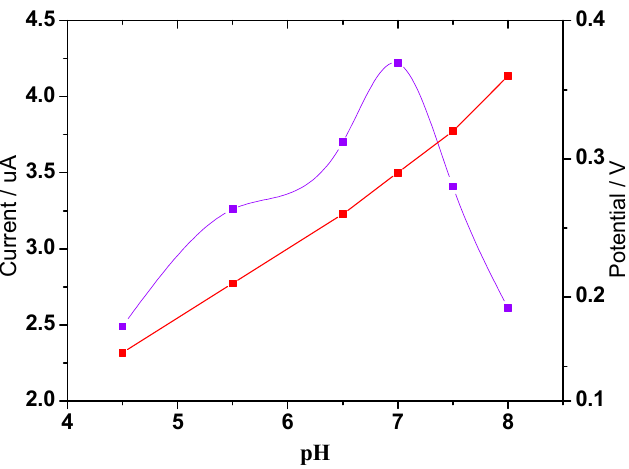
Figure 5. Effect of pH on the peak current and reduction potential of 5 μ M of phenol at the surface of SPCE/Gr-Au-Chit/Tyr in the presence of 0.1 M PBS pH 7.0.